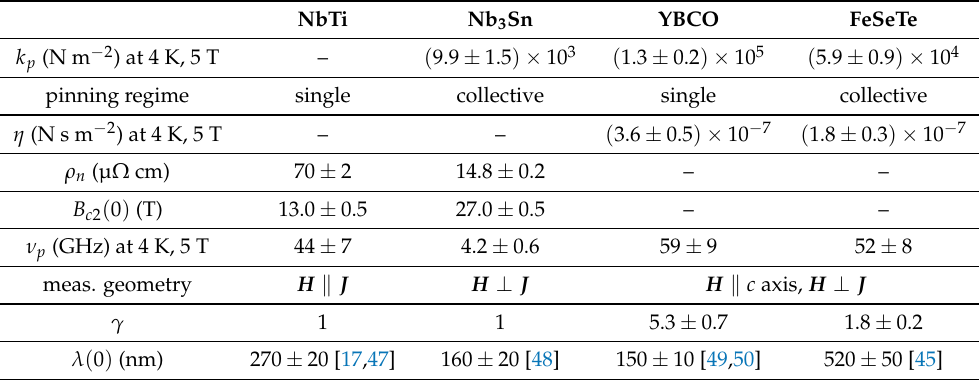
Table 2. Measured parameters of the SCs of interest used for the evaluation of R s